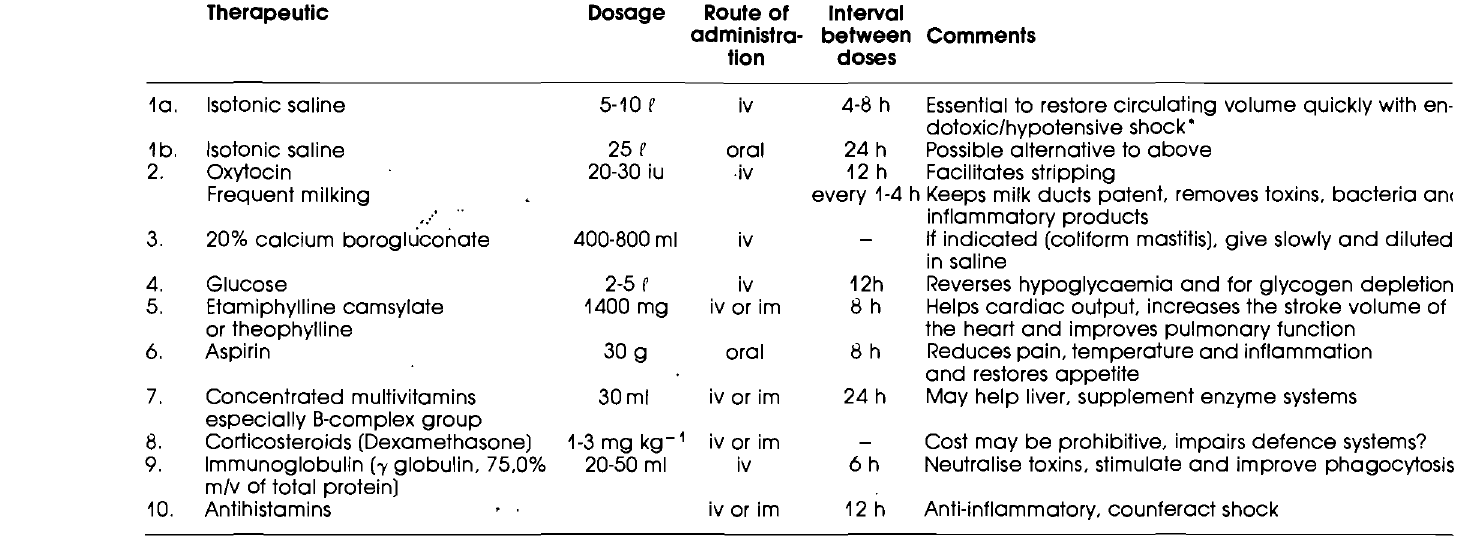
Table 5. Supportive therapy for cows with acutelperacute mastitis Therapeutic Dosage Route of Interval